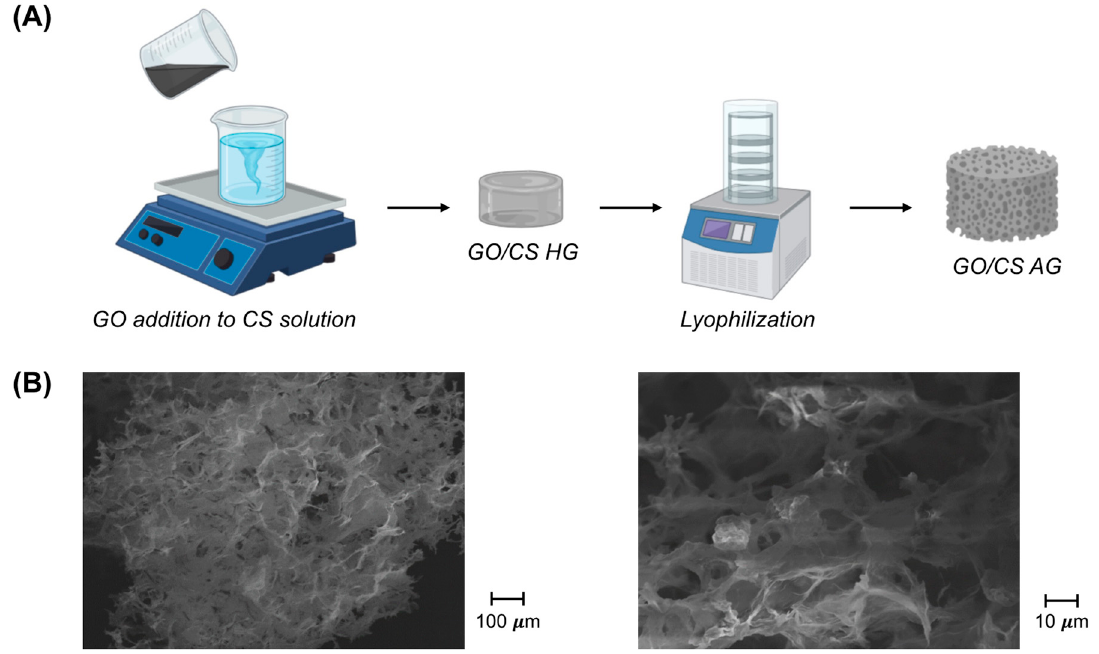
Figure 1. ( A ) Schematization of the synthetic procedure for GO/CS AG formation. ( B ) SEM images at two different magnifications, as indicated.